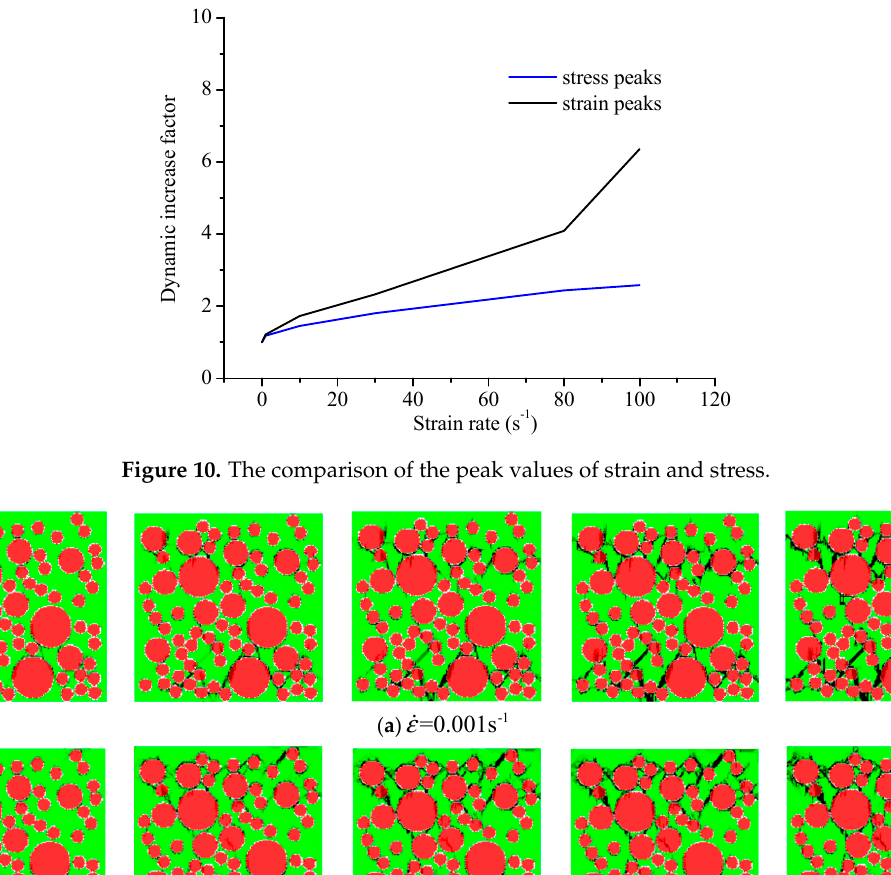
Figure 9. Stress–strain curve of concrete under dynamic uniaxial compressive stress at different strain rates.